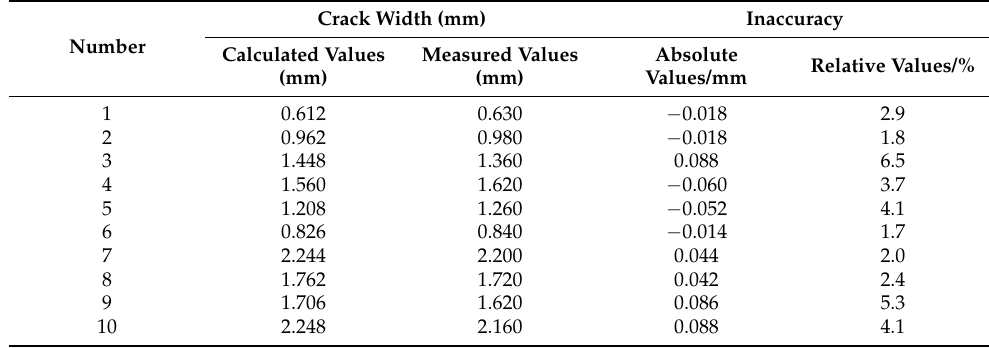
Table 4. Comparison of measured values of maximum crack